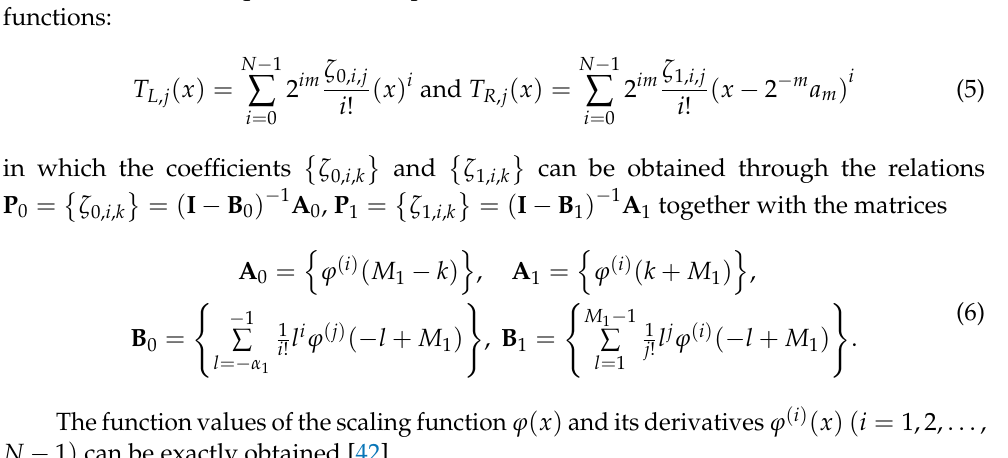
Figure 1. The scaling function and wavelet function of the Coiflet with N = 6, M 1 = 7. In addition, in Equation (4), the parameters